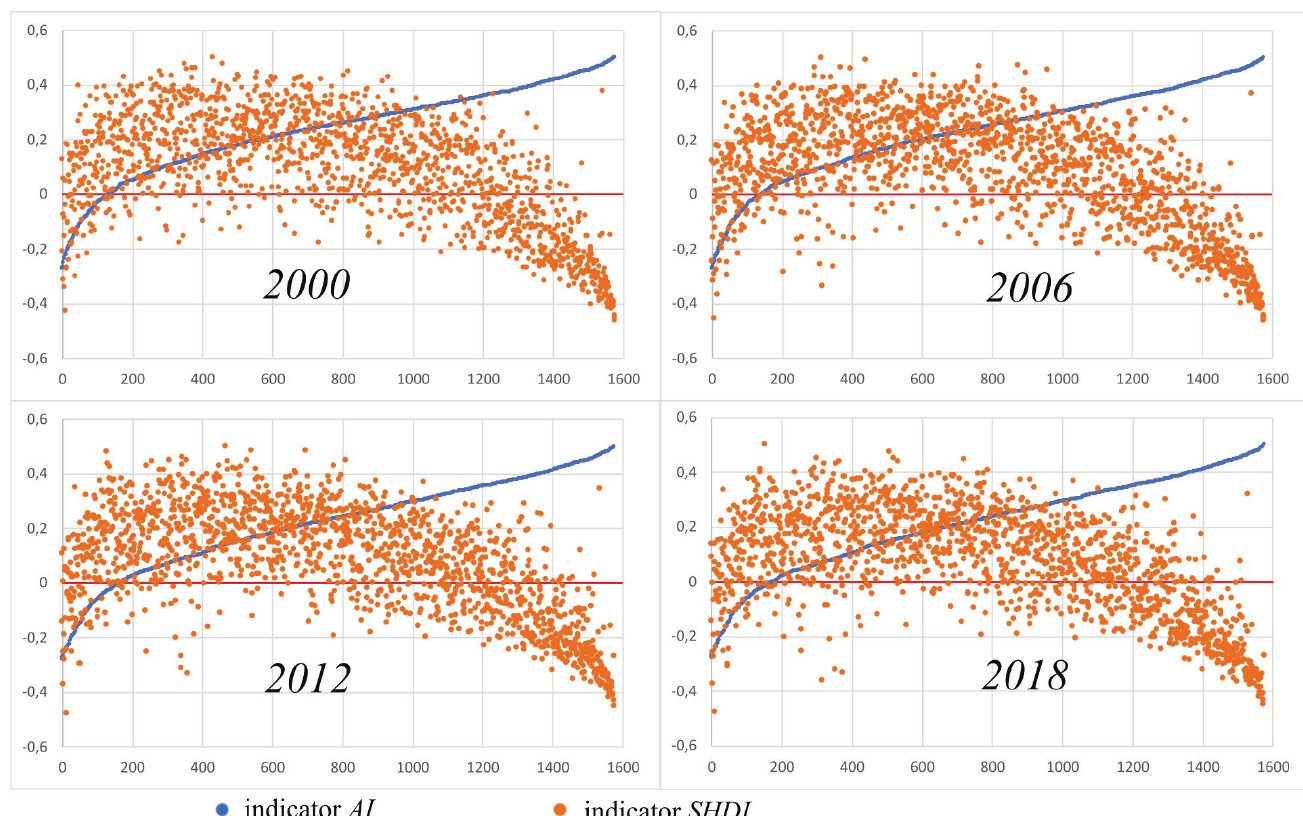
Figure 4. Distribution of AI and SHDI values in PFs for 2000, 2006, 2012 and 2018